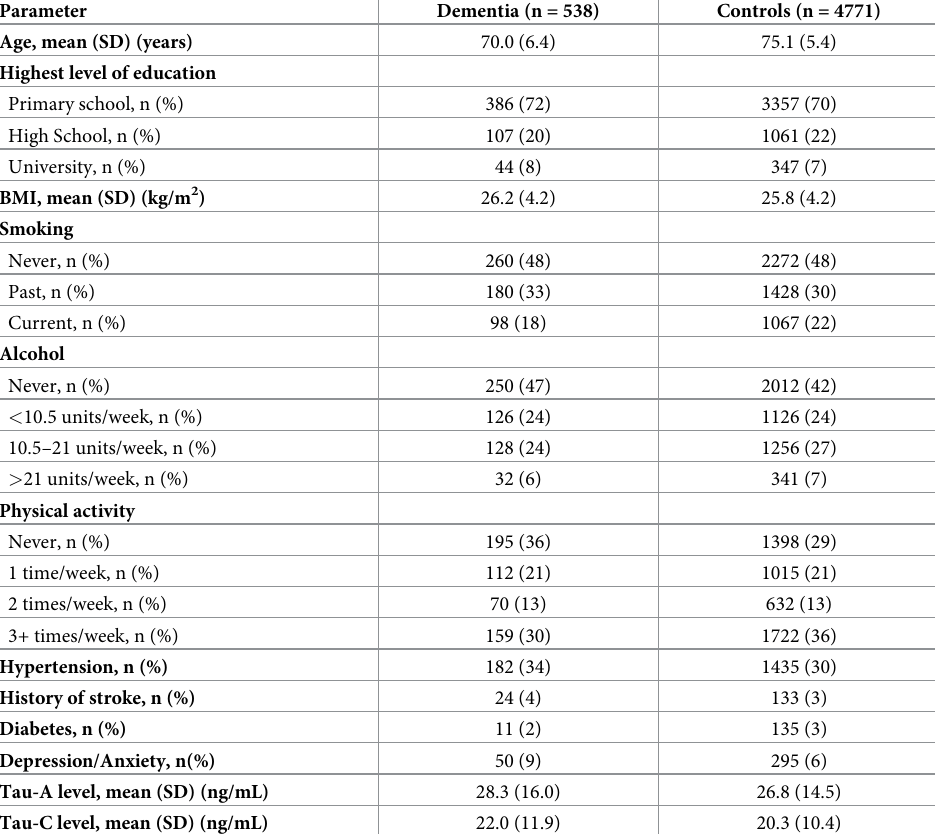
Table 1. Study population characteristics at baseline. Numbers are shown as absolute numbers with percentile in brackets for categorical variables. For numerical variables, the mean (standard deviation) is